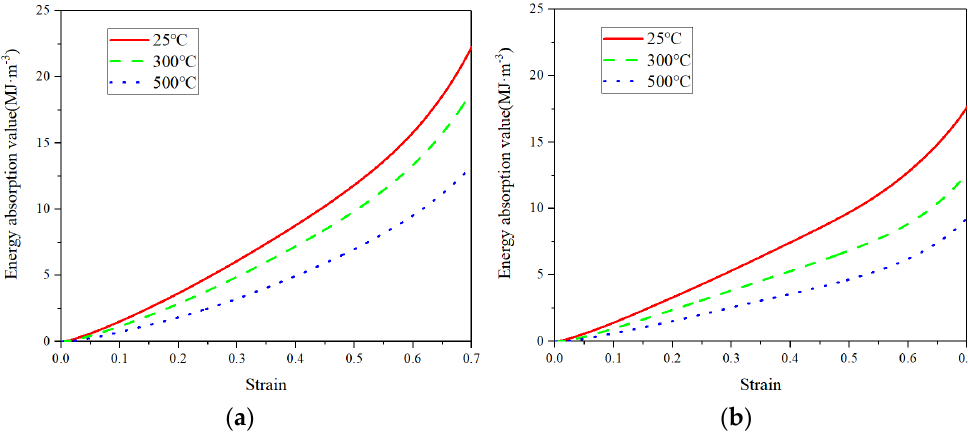
Figure 10. Curves of energy absorption per unit volume of CCCFs with ( a ) uniform pores and ( b ) graded pores at the different temperatures, as a function of the compressive strain ε